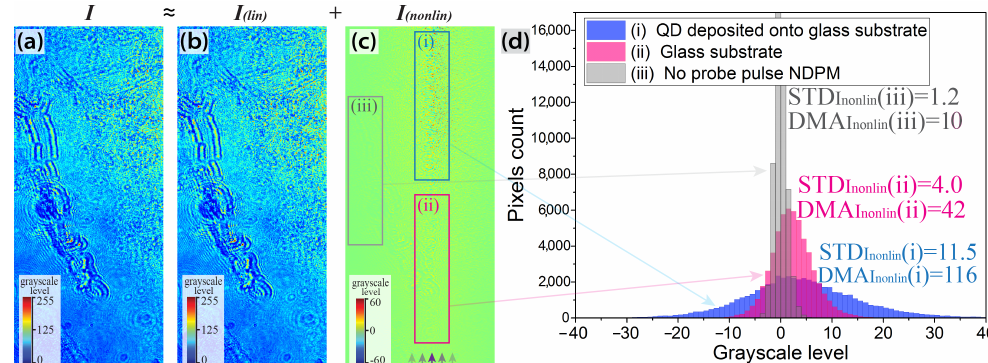
Figure 3. Examples of ( a ) an inline digital holograms recorded at the delay time t 1 , ( b ) a “basic” diffraction pattern I lin as observed without pump pulse, and ( c ) the diffraction pattern of the probe pulse I nonlin induced by its NDPM on the pump pulse in the area of their intersection inside the sample (purple arrows indicate the area of two pulses intersection). Notice the different legend ranges in the figures. ( d ) Examples of grayscale level histograms within the three areas of the I nonlin diffraction patterns of (i) QDs deposited on the glass substrate, (ii) the pure sample glass only, and (iii) no intersection between pump and pulses inside the sample. Standard deviations of the histograms STD I and diffraction pattern modulation amplitude DMA are indicated for the nonlin three